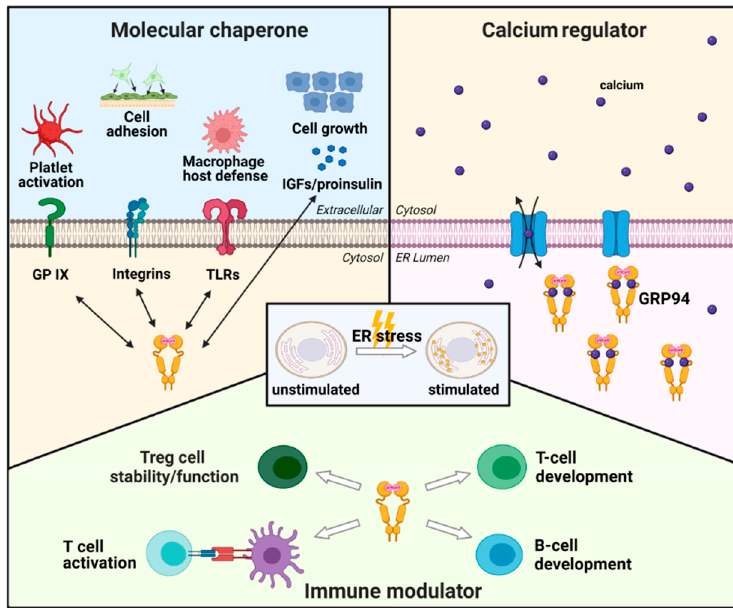
Figure 2. Schematic representation of the physiological roles of GRP94. GRP94 is a molecular chaperone upregulated by ER stress. Under stress conditions, GRP94 accelerates its function as a molecular chaperone. Client proteins of GRP94 include toll-like receptors (TLRs), glycoprotein (GP) IX subunit, insulin-like growth factors (IGFs), proinsulin, and integrins. These interactions are closely associated with direct function in macrophage host defense, activation of platelets in blood clotting, cell growth, and cell adhesion. Calcium regulation is another physiological function of GRP94, one of the major calcium-binding proteins in the ER regulating calcium homeostasis. Lastly, GRP94 is a multifunctional immune modulator. As demonstrated, GRP94 is essential in early T- and B-cell development while also regulating Treg cell stability and immunosuppressive function. GRP94 activates T-cells through peptide binding.